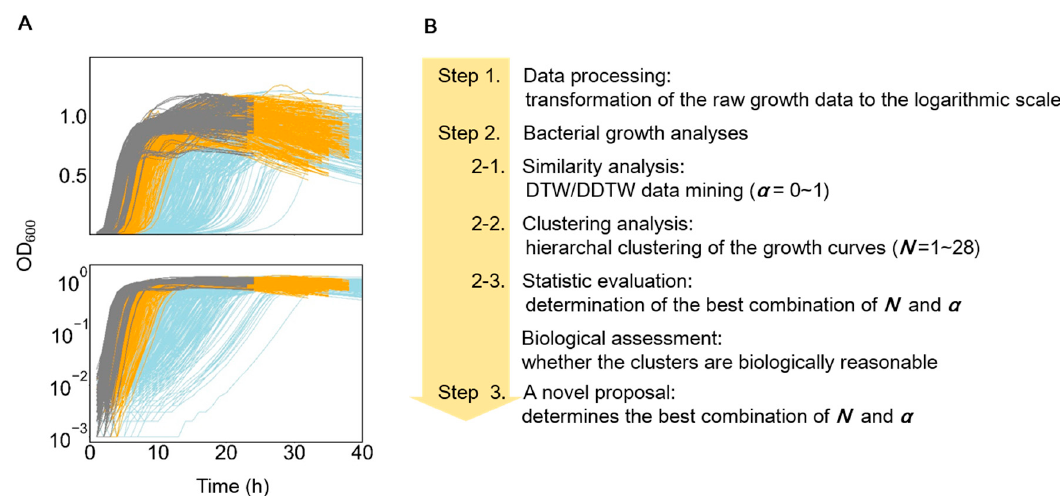
Figure 1. Overview of the growth data and analytical approach. ( A ) Bacterial growth curves used in the present study. A total of 28 E. coli strains were grown in the LB (gray), MAA (yellow) and M63 media (blue). The top and bottom panels represent the growth curves shown in the linear and logarithmic scales, respectively. ( B ) Scheme of the analytical approach used in the present study. Three steps (Steps 1–3), including data processing, growth analyses, and a novel proposal were